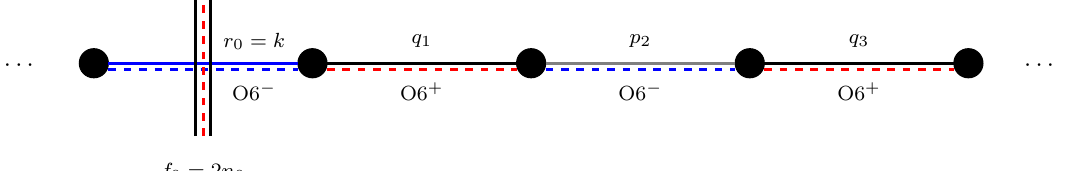
(a) NS5-D6-O6-D8-O8 con(cid:12)guration with O8 + -plane between an NS5 and its image, and crossing the 0-th D6-O6 (cid:0) stack. A red vertical dashed line paired up with two black lines represent an O8 + overlaid onto n 0 pairs of D8-branes, engineering a USp(2 n 0 ) (cid:13)avor symmetry and contributing 2 n 0 half-hypermultiplets. A blue (black/gray) horizonatal line represents a D6 stack engineering an SU ( USp/ SO) gauge group.